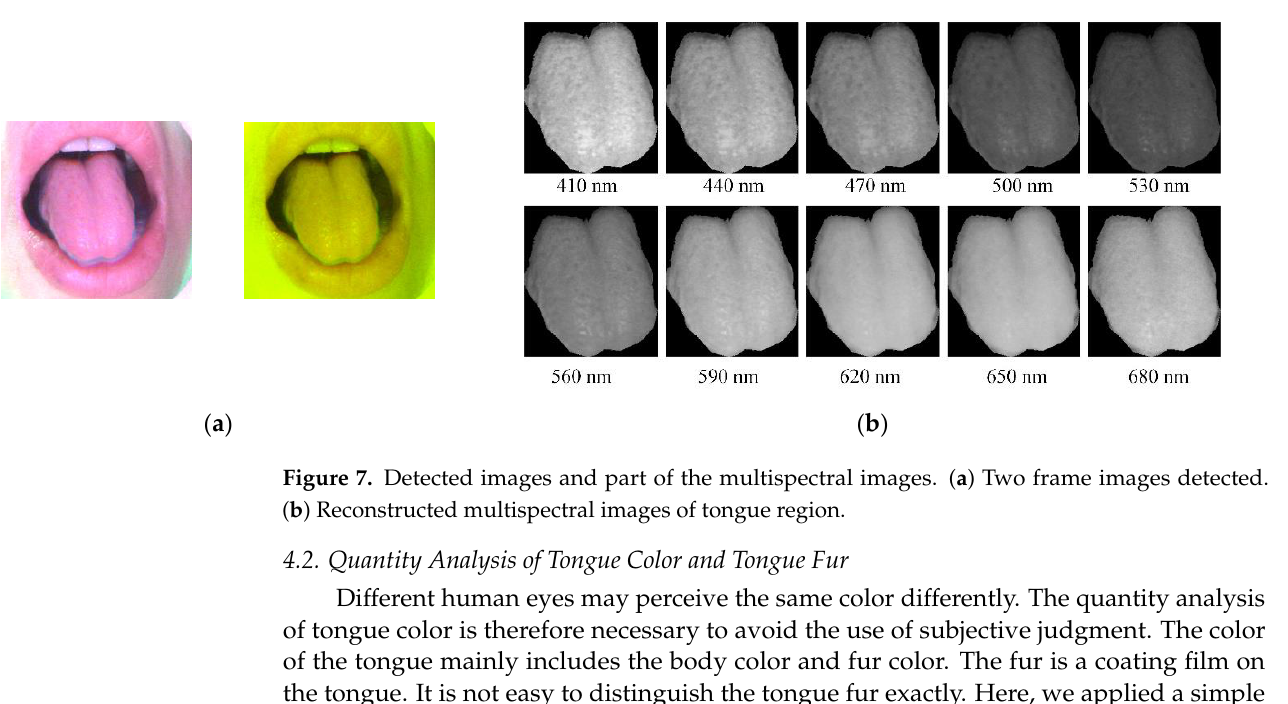
Figure 7. Detected images and part of the multispectral images. ( a ) Two frame images detected. ( b ) Reconstructed multispectral images of tongue region.